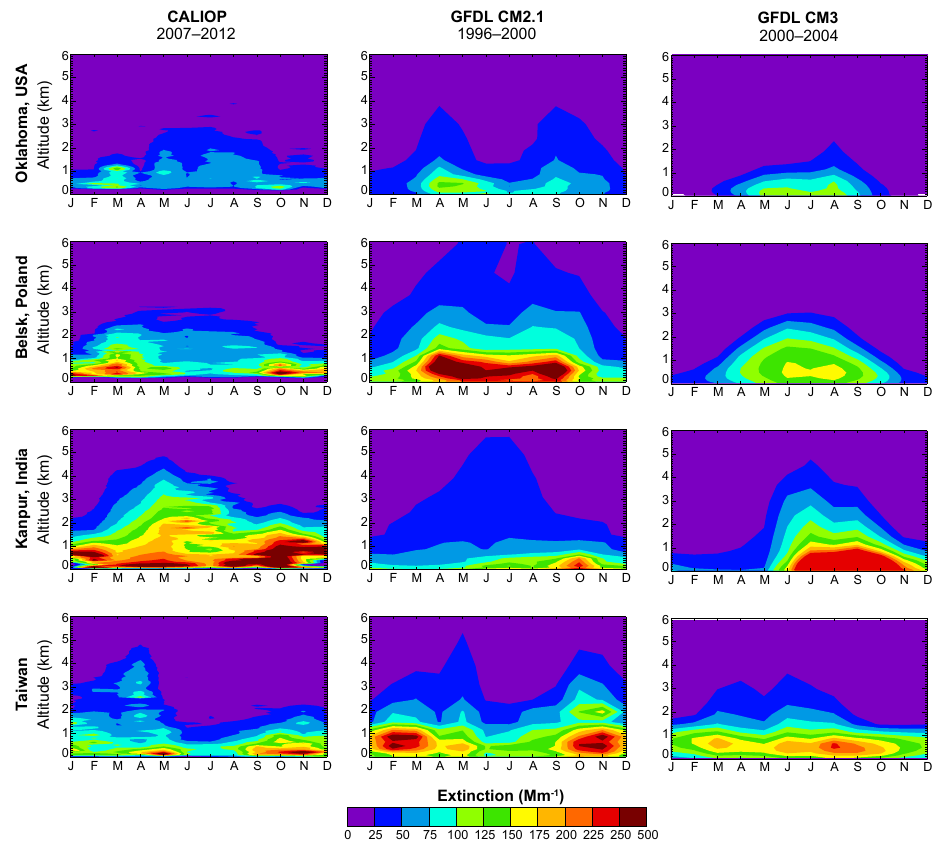
Figure 9. Extinction coefficients (Mm − 1 ) from CALIOP (left panels) and the models (CM2.1: middle panels, CM3: right panels) for four industrialized sites. CALIOP extinctions measured at 550nm; model parameters calculated at